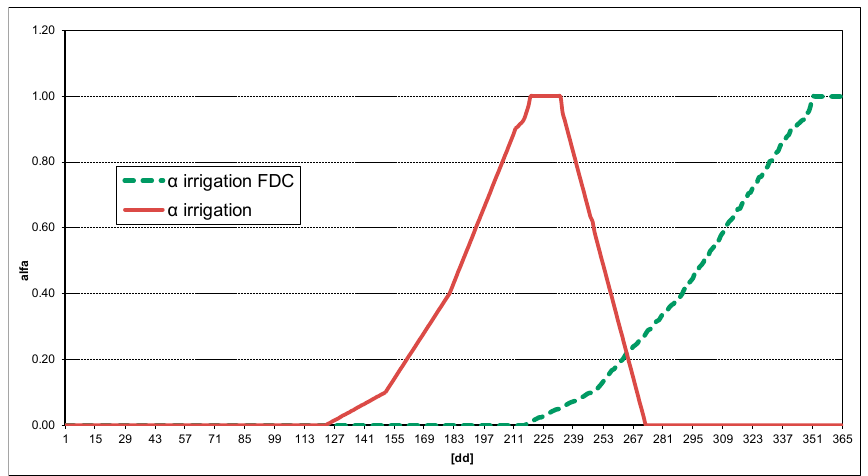
Figure 2. Alpha ( α ) standard coefficient for irrigation water abstraction.